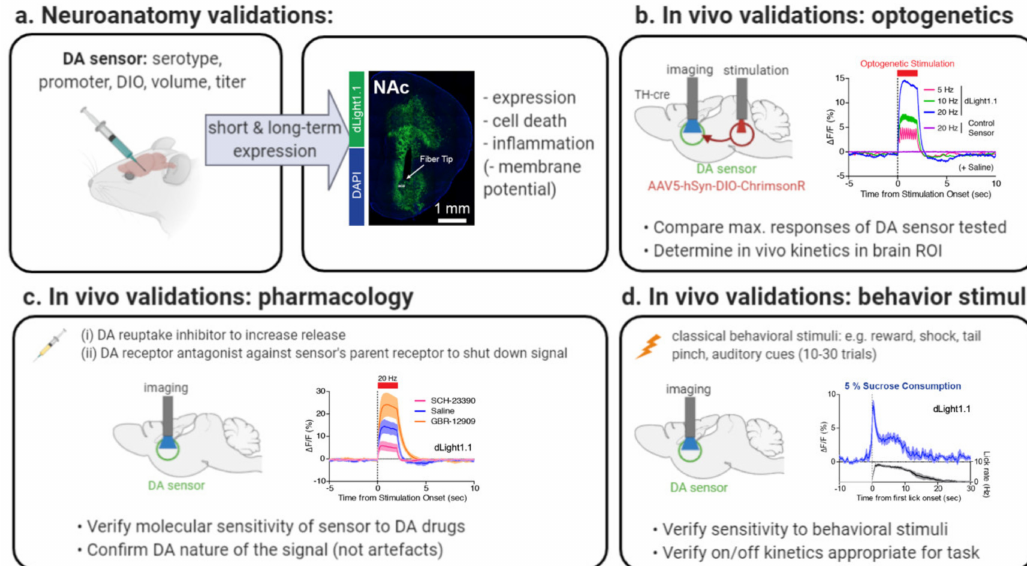
Figure 7. Piloting sensor use in the laboratory can follow these four steps: ( a ) First, optimal sensor expression in the region or cell of interest should be achieved by optimizing viral injections parameters, often based on protocols previously established in the laboratory for other viral vectors. After a minimum of 2 weeks of incubation, sensor expression can be evaluated as shown here for dLight1.1 in the nucleus accumbens (NAc) [58]. If experiments are expected to last more than 2 months, additional tests can be performed to verify that sensor expression does not induce cell death (e.g., caspase-3 staining) or inflammation (e.g., staining for reactive microglia or astrocyte markers), nor does